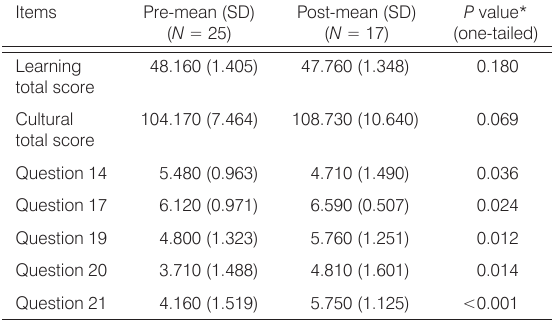
Table 2. Findings from mean comparison of pre- and